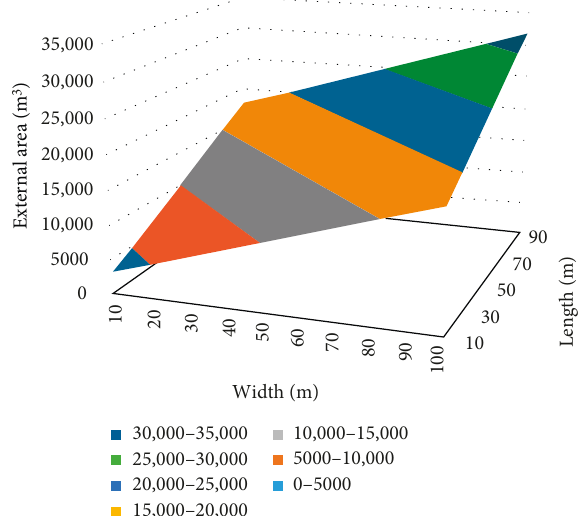
Figure 9: Changes in physical properties according to mass scale: envelope area (m 2 ).